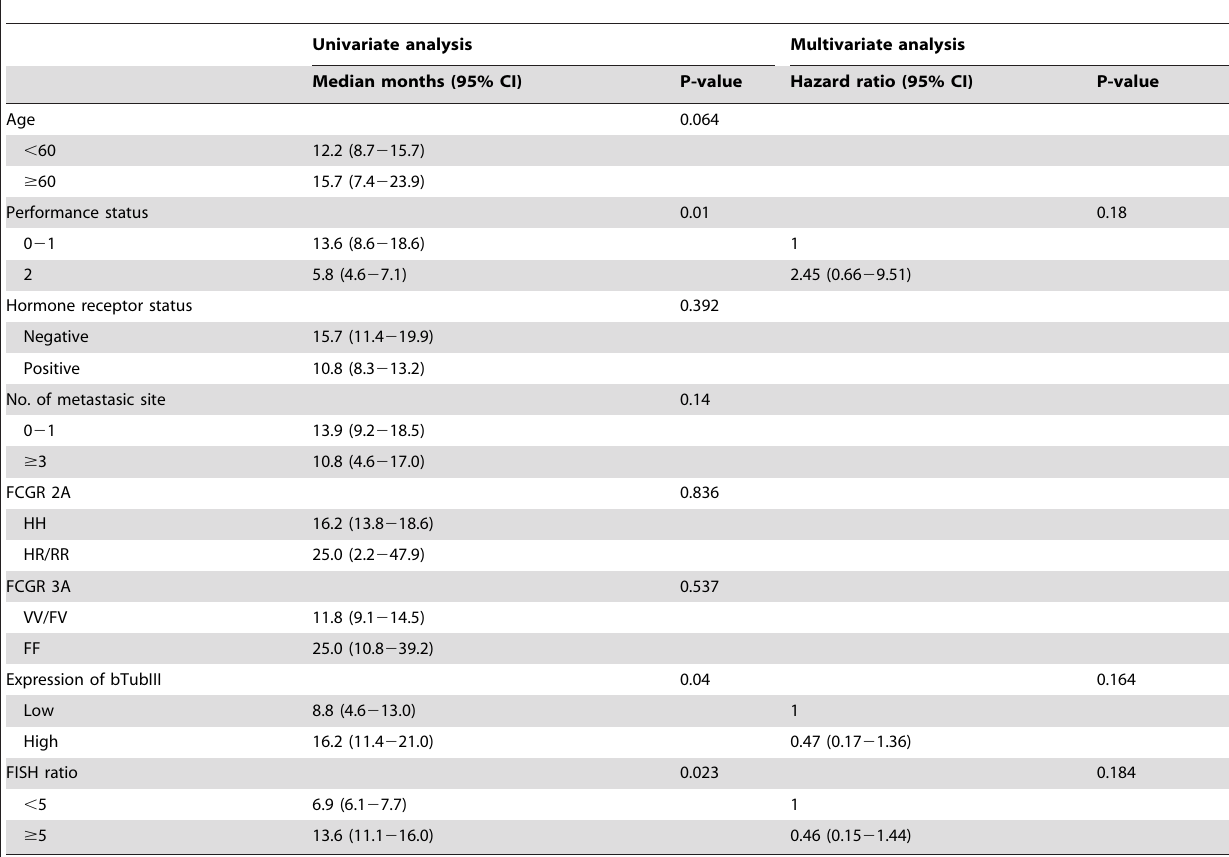
Table 4. Univariate and multivariate analysis for progression free survival.